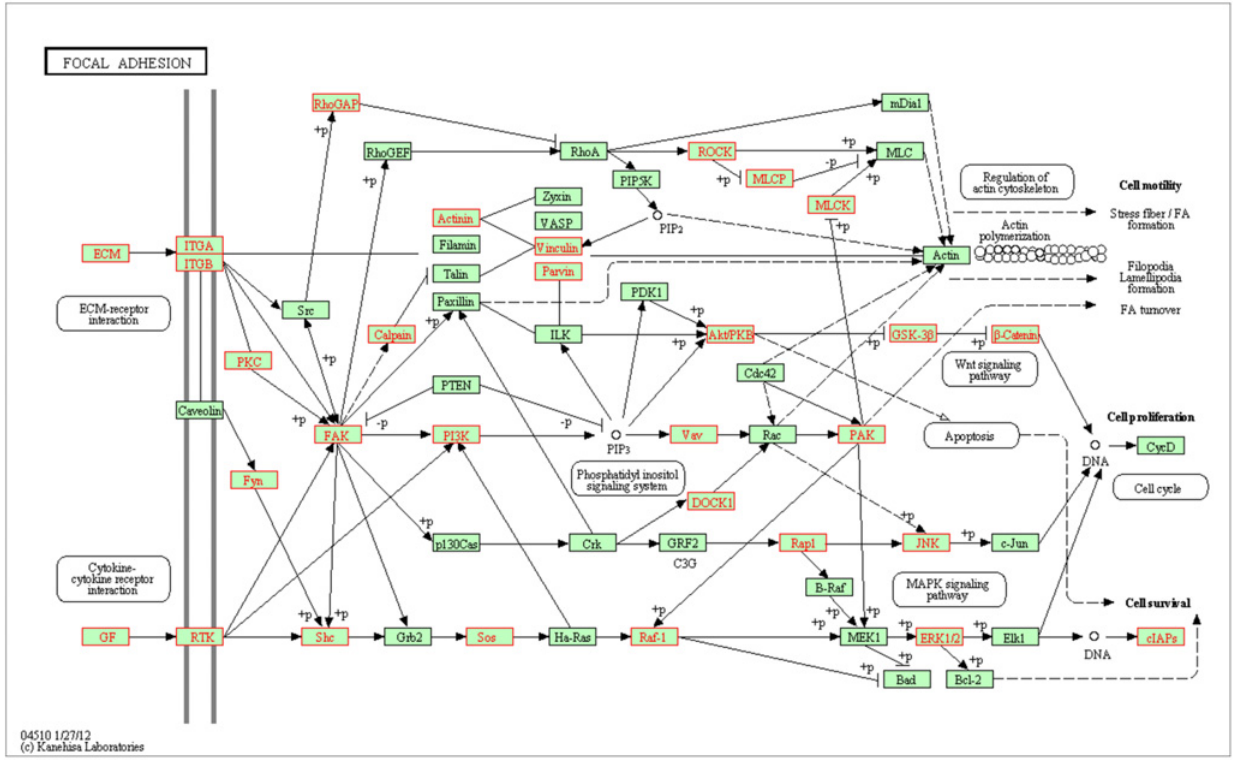
Fig 8. Functional gene enrichment of the KEGG focal adhesion pathway. Differentially regulated genes were mapped onto a KEGG pathway (hsa04510) that was found to be enriched between the culture conditions. Genes highlighted red indicates probes downregulated on PAA (FC < -2), including ITGA, ITGB, PKC, Fyn, RhoGAP, FAK, PI3K, Calpain, Actinin, Vinculin, Parvin, Vav, DOCK1, Rap1, JNK, ERK1/2, GSK-3 β , β -Catenin, MLCP, ROCK, RTK, Shc, Sos, Raf1. No probes highlighted were upregulated on PAA (FC > 2) within this